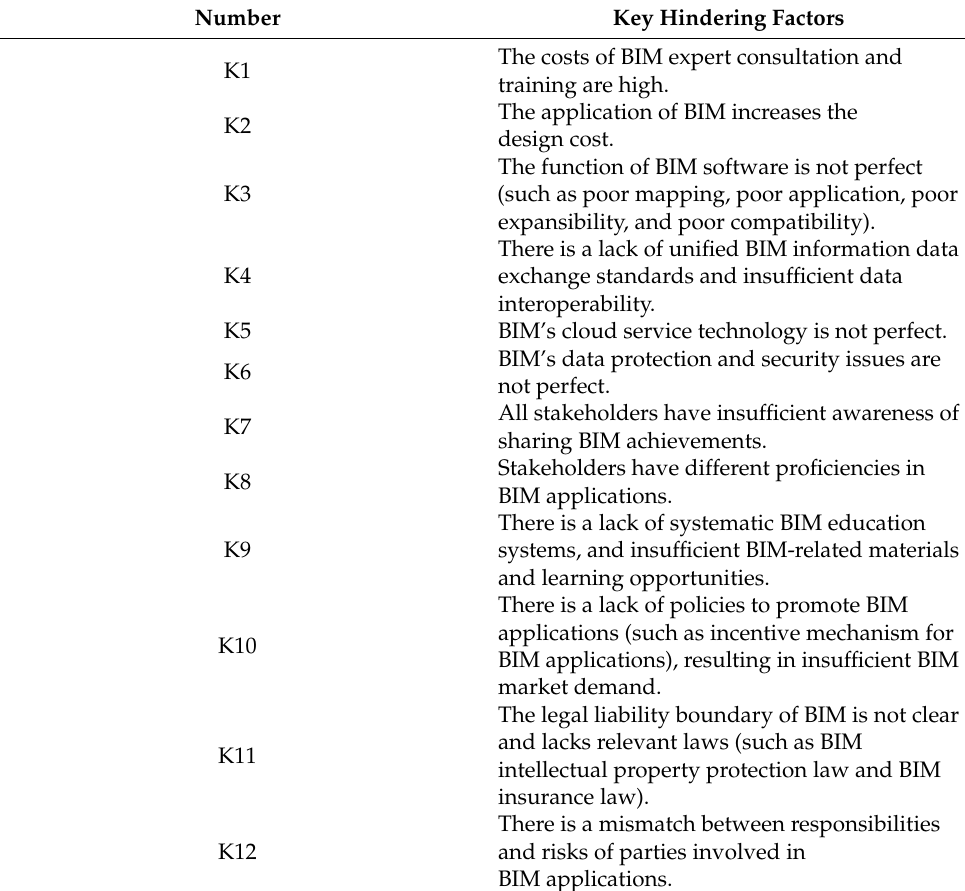
Table 6. The key hindering factors of BIM